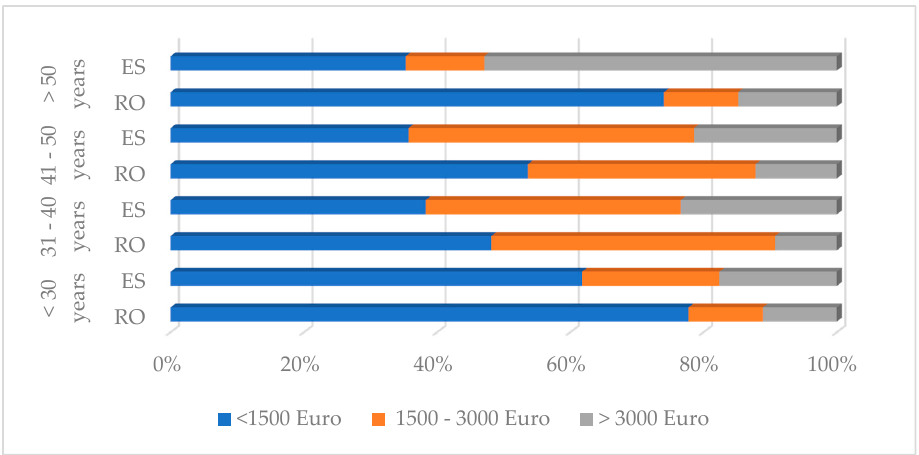
Figure 8. The distribution of hunters according to the age and annual budget for hunting.